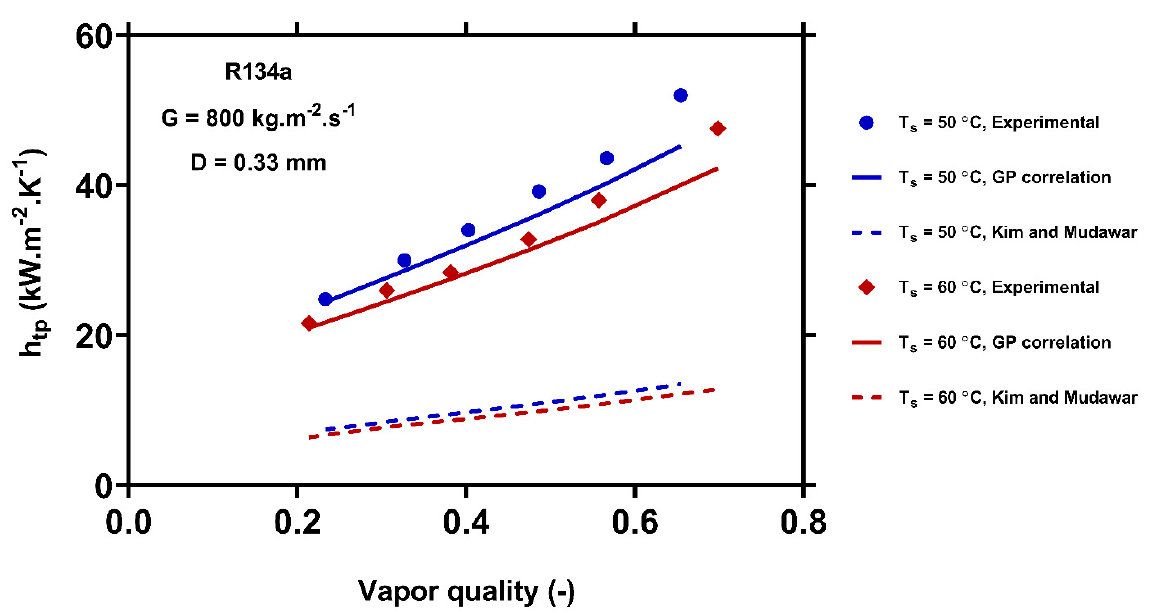
Figure 5. Comparison of the predictions of the GP correlation (Equation (13)) and the model of Kim and Mudawar [52] with the experimental data [72] for R134a condensing at the mass flux of 800 kg · m − 2 · s − 1 inside a 0.33 mm channel under different saturation temperatures. Blue and red points represent the T s = 50 ◦ C and T s = 60 ◦ C, respectively. The solid points, solid lines, and dash lines represent the experimental values, GP outcomes and Kim and Mudawar [52] outcomes.